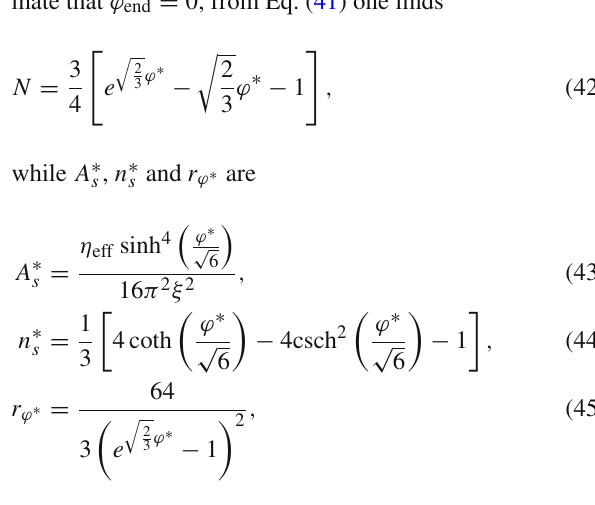
= 1, while orange points are for c χ the minima c χ 0 The scanned points in Fig. 1 are traced back to low scale